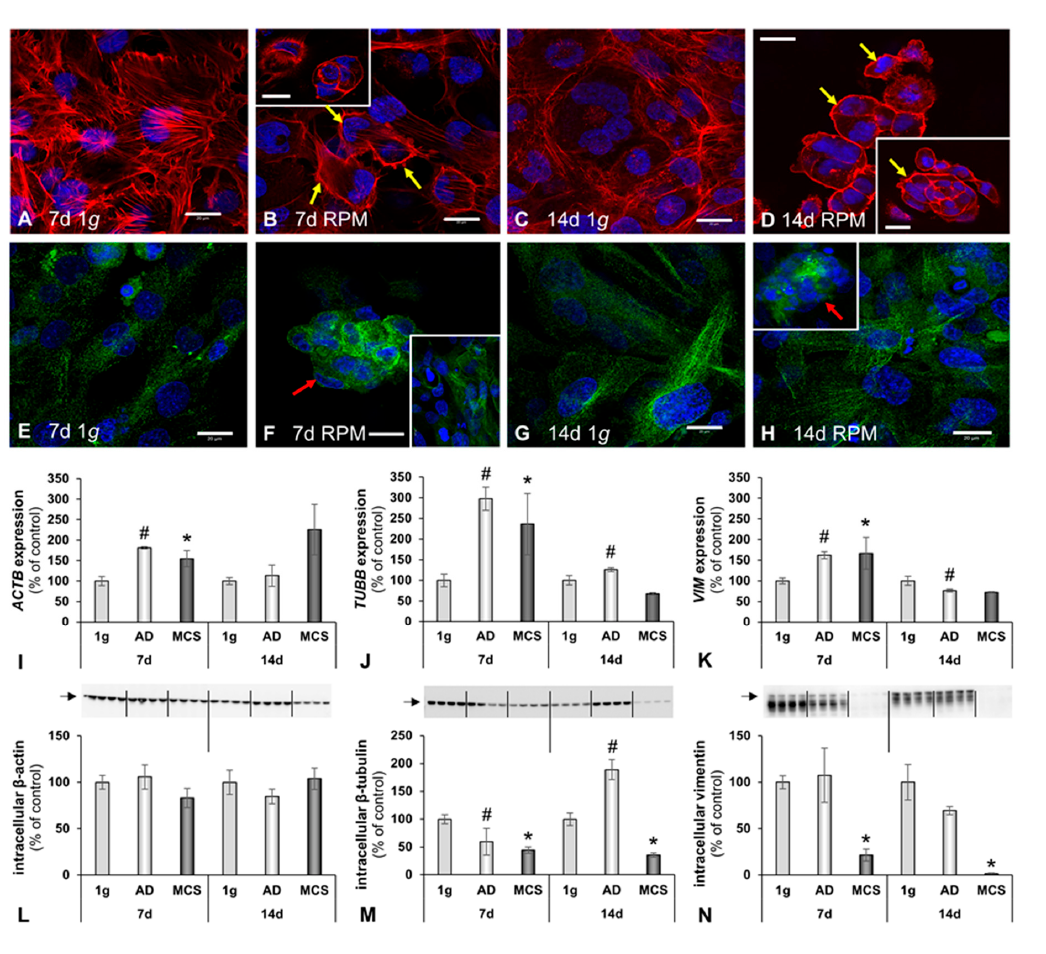
Figure 3. Influence of simulated microgravity on the cytoskeleton of human osteoblasts. Phalloidin– rhodamine staining visualized the F-actin distribution in the 1 g control cells ( A,C ) and RPM-exposed cells ( B,D ). The yellow arrows indicate filopodia and lamellipodia, as well as the accumulation of F-actin at the outer cellular membranes. ( E – H ) Tubulin immunofluorescence: Red arrows indicate holes in the tubulin network in spheroids. Gene expression of selected cytoskeletal genes: ( I ) β -actin ( ACTB ), ( J ) β -tubulin ( TUBB ) and ( K ) vimentin ( VIM ). Intracellular protein levels. ( L ) β -actin, ( M ) β -tubulin and ( N ) vimentin. All values are given as mean ± standard deviation. # p < 0.05 1 g vs. AD; * p < 0.05 1 g vs. MCS. Scale bars: 20 μ m, d, days.